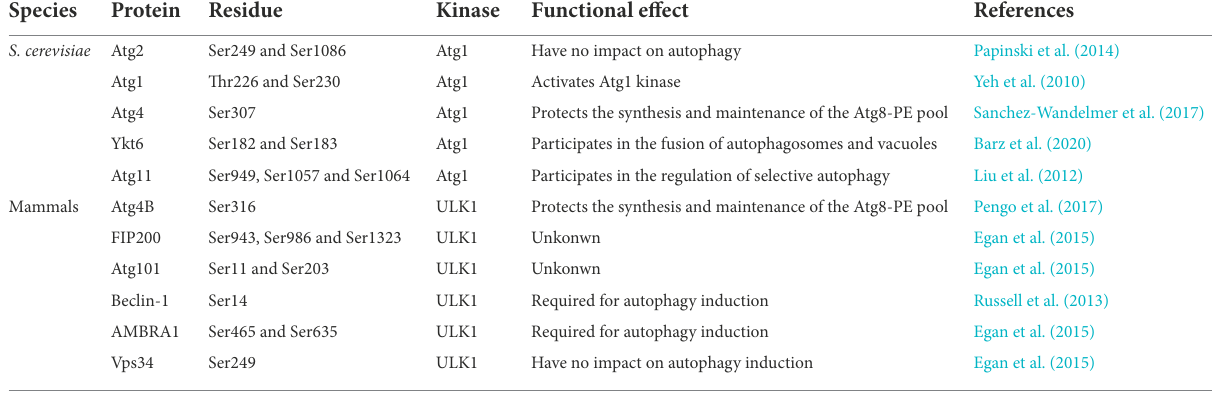
TABLE 3 The Atg1/ULK1 kinase phosphorylates downstream substrates.